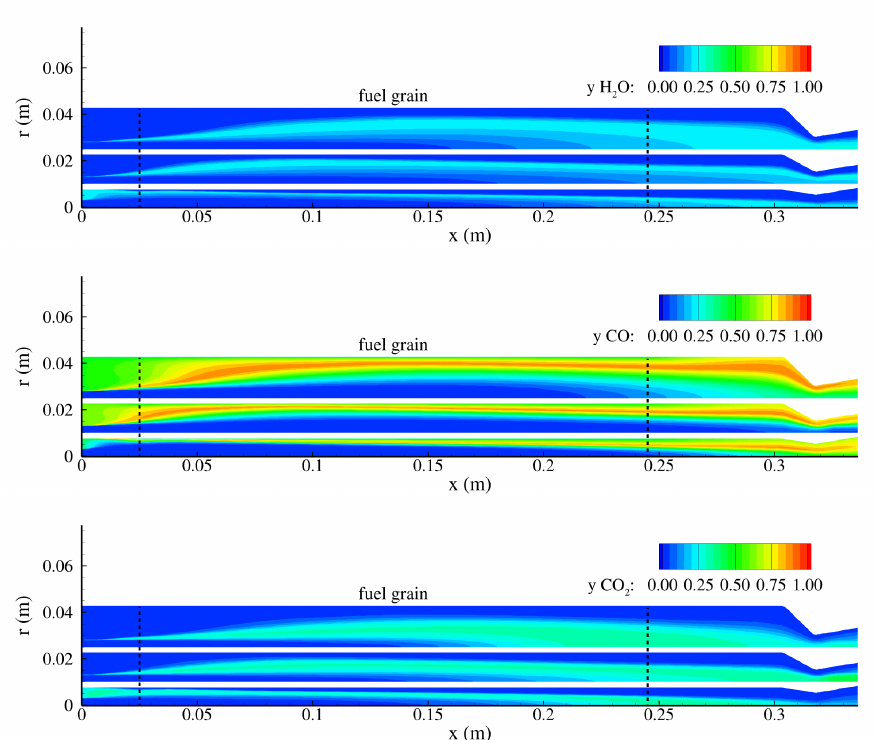
Figure 4. Mass fraction contours of water vapor, carbon monoxide, and carbon dioxide for test 4 of set 1 at different port